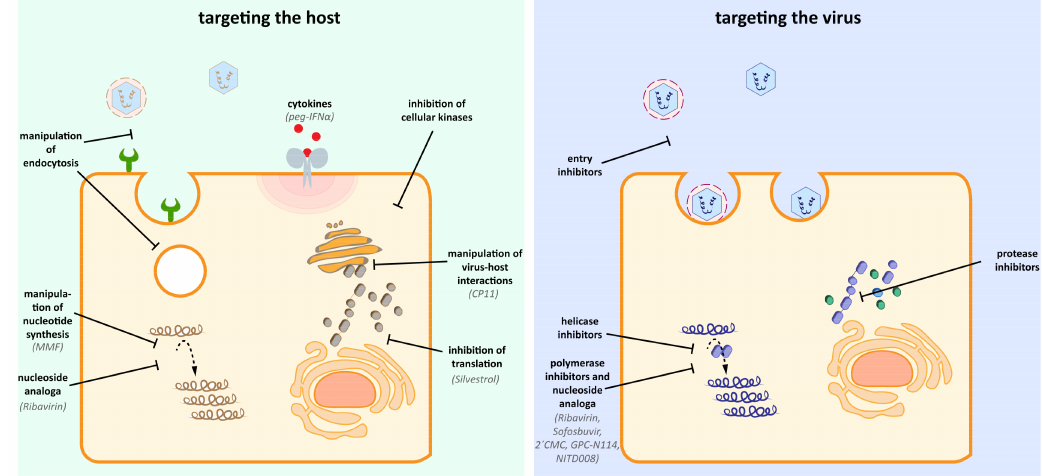
Figure 2. Potential host and viral targets of antiviral drugs. Antiviral therapy against HEV can rely on the inhibition and manipulation of host components, which are important for the HEV life cycle. Additionally, direct acting antiviral specifically can target viral enzymes (e.g., helicase, polymerase, protease) without a ff ecting host components. Notably, the nucleoside analog Ribavrin is reported to exert antiviral e ff ects by targeting both the virus and the host